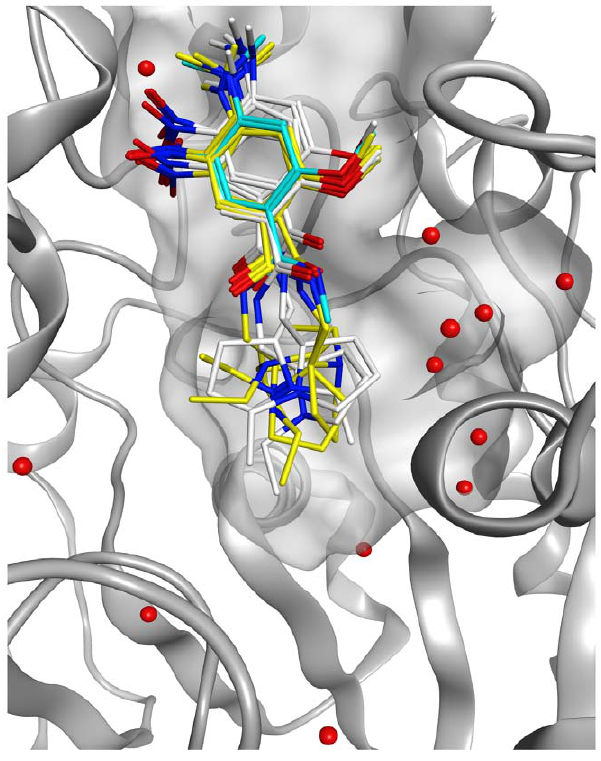
Figure 7. Predicted binding poses of both C5685 enantiomers by molecular docking simulations. Poses of C5685 ( R ) and C5685 ( S ) that were generated using the modified parameter settings in Glide are shown with carbons colored white and yellow, respectively. The part of C5685 as modeled in the X-ray crystal structure is shown with carbons colored in cyan, and the 12 conserved water molecules that were included in the docking simulations are indicated in red.